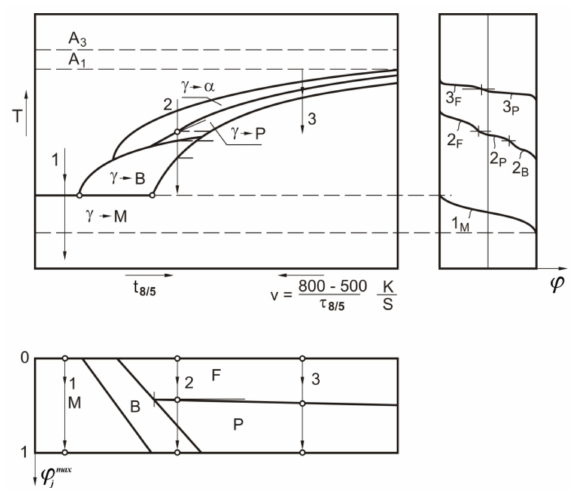
Figure 5. Diagram of supercooled austenite